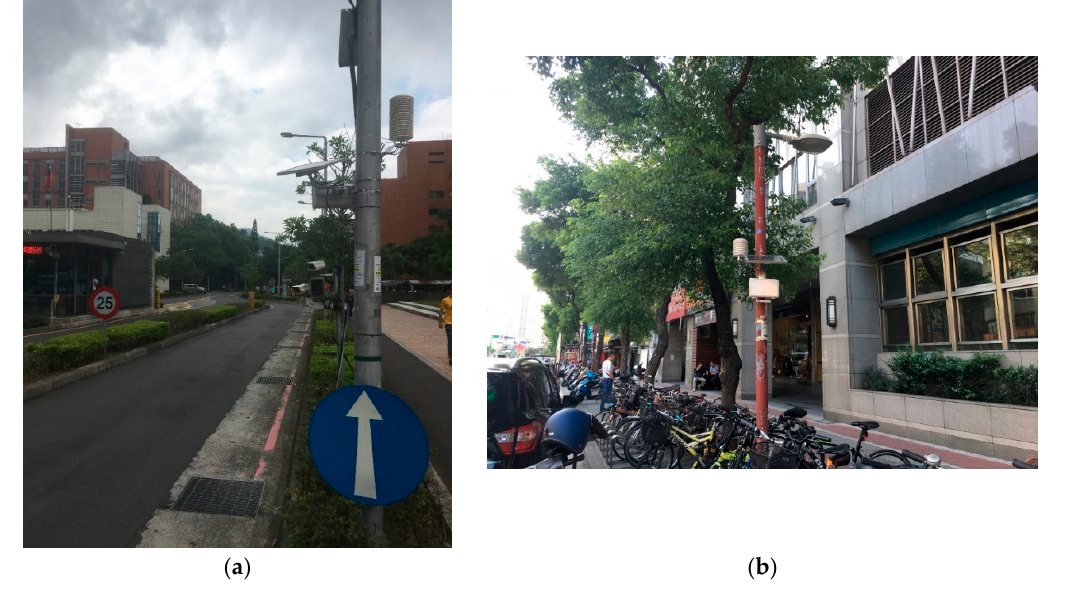
Figure 4. Site photos for AS-LUNG-O sets at ( a ) Location A and ( b ) Location B.